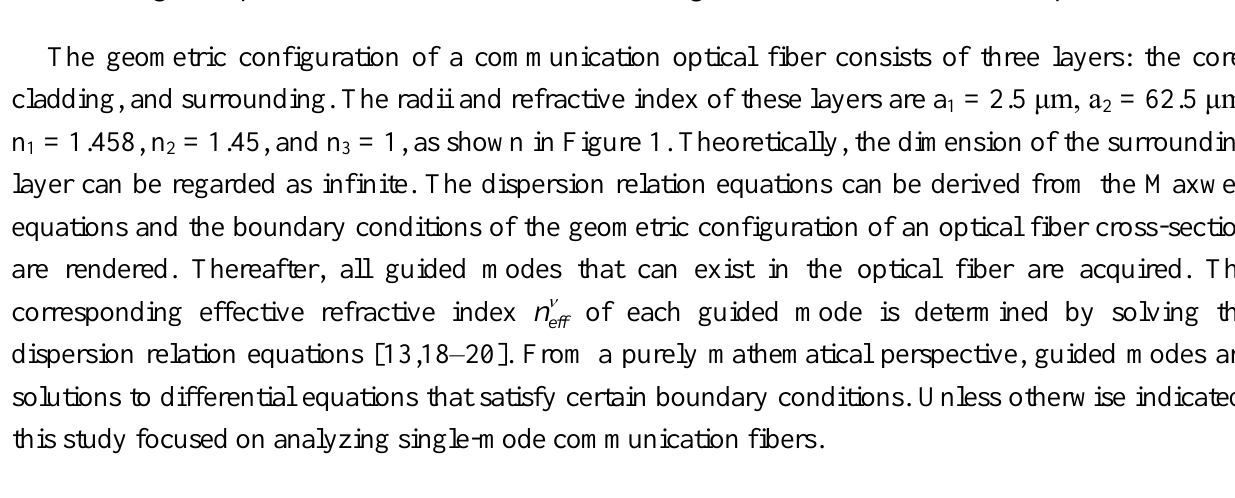
Figure 1. The geometric configuration of a communication optical fiber with